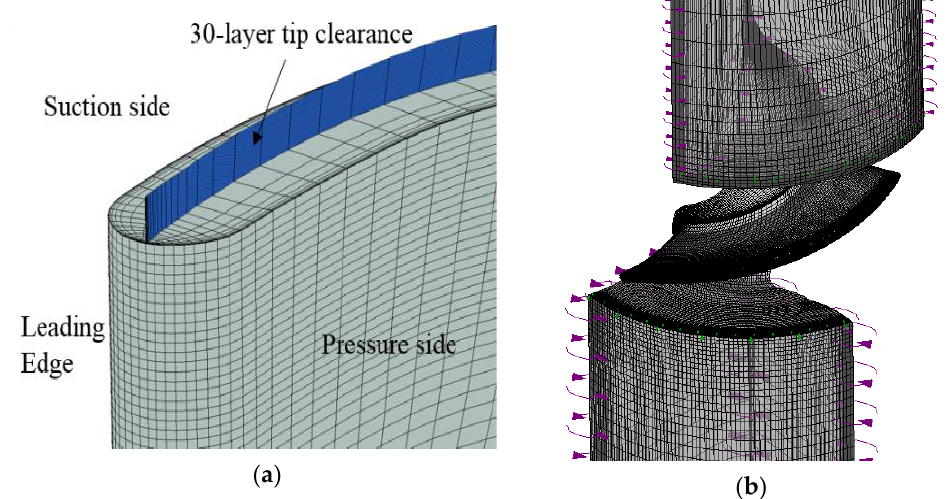
Figure 4. Mesh formation. ( a ) Fine mesh at tip clearance; ( b ) structured grid for calculation domains.